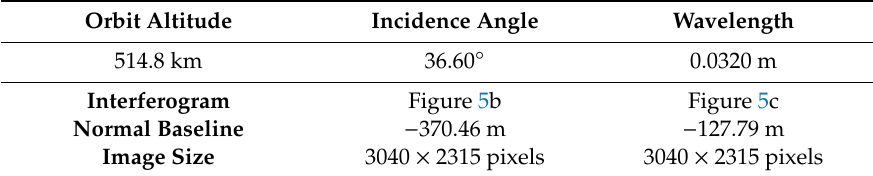
Table 4. The parameters of real multi-baseline (MB) InSAR datasets. Table 5. Root mean-square error (RMSEs) of TanDEM-X DEM assessed using ICESat data points (unit: meters).